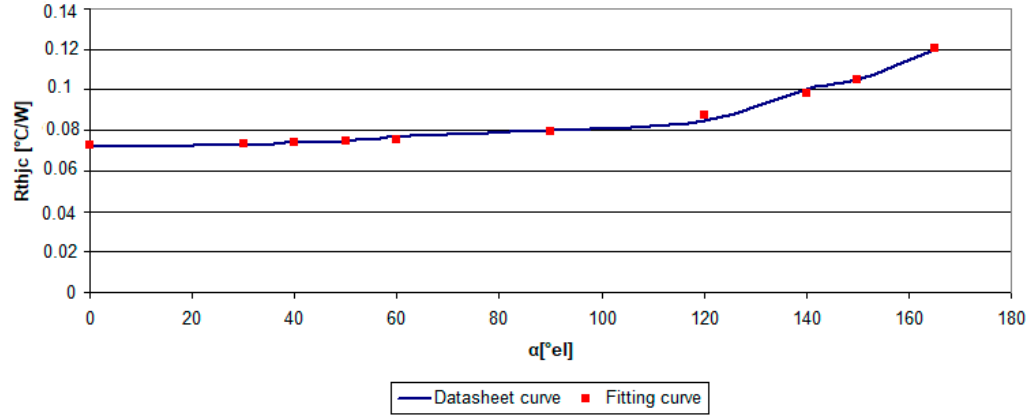
Figure 3. Comparison between datasheet and fitting curve for the junction-case thermal resistance variation against firing angle.